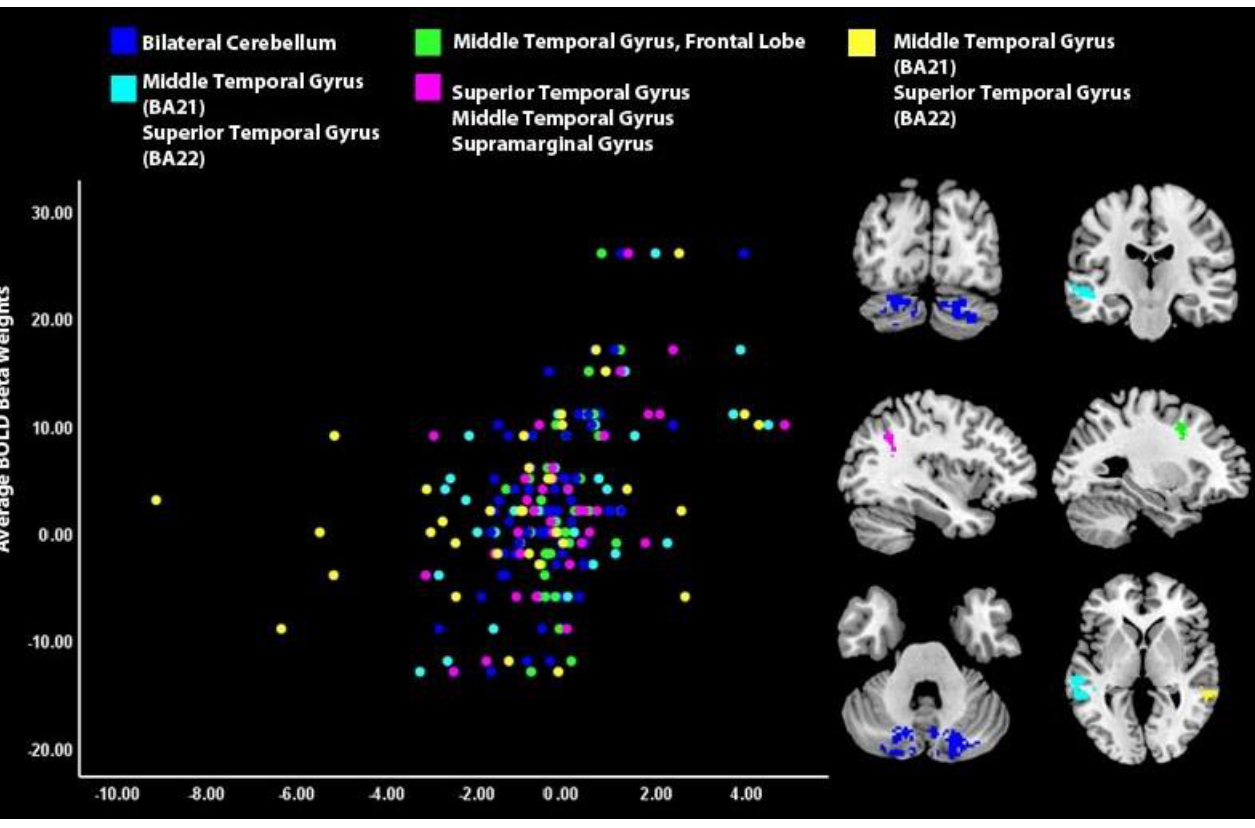
Figure 2. Brain activity associated with symptom change during neurofeedback (feedback vs. count — backwards) in depressed youth, n = 34: ( a ) Changes in brain activity during neurofeedback vs. counting backward associated with decreased rumination; ( b ) Changes in brain activity during neurofeedback vs. count — backwards associated with decreased depression.